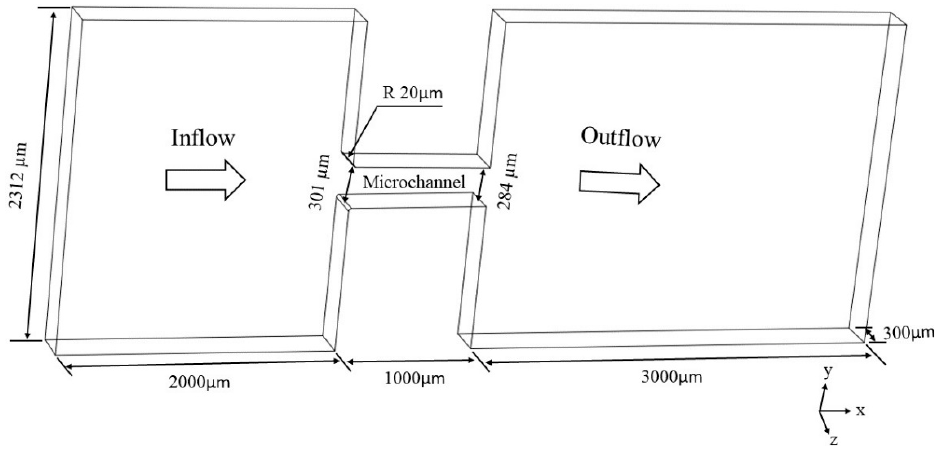
Figure 2. The simulation calculation model of the microchannel structure. Table 1. ISO4113 fuel thermophysical properties.